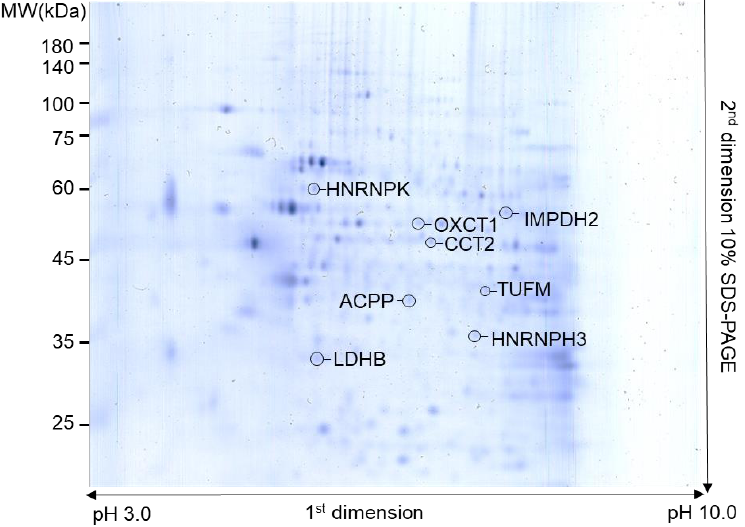
Figure 1. 2DE analysis and identification of protein spots showing significant changes in expression between the control group and DHT-or FSK-treated groups. Representative gel showing eight protein spots with significant changes in expression (density) among DHT-, FSK-treated groups, and the control group as well as the identification of proteins by MS analysis.